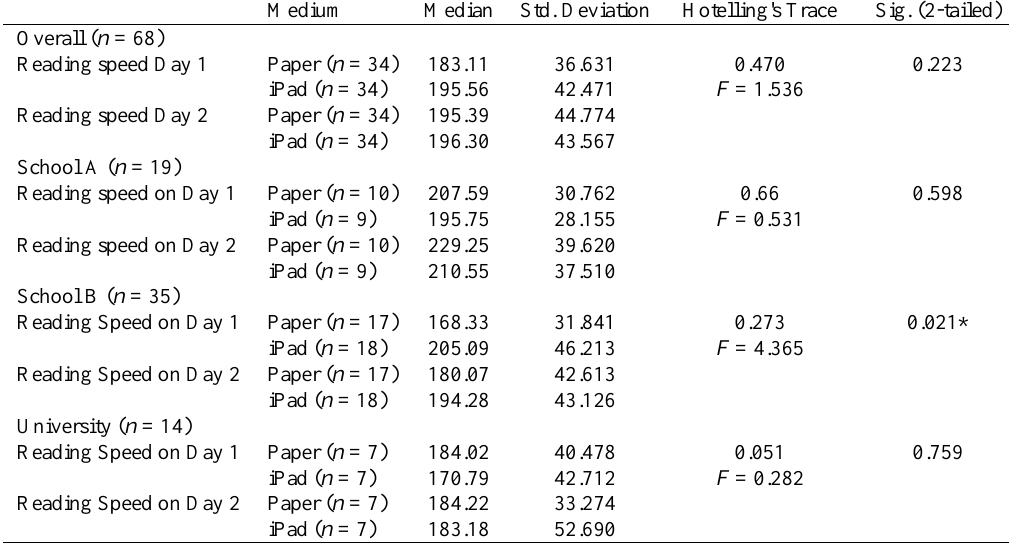
Table 3 Reading speed with Multivariate